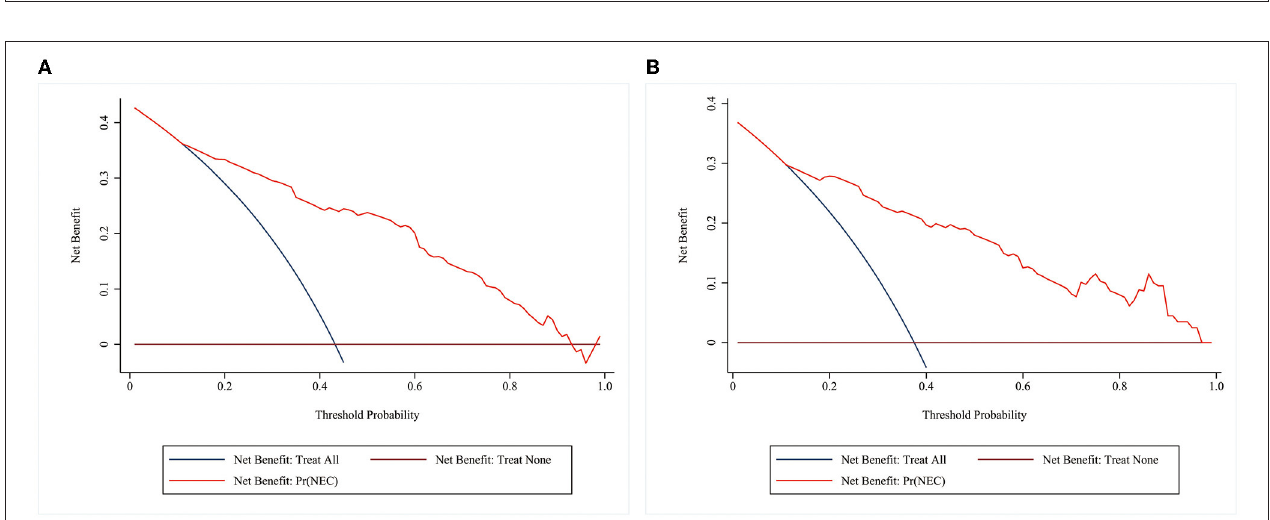
FIGURE 4 | Calibration curves of the models in the training and validation groups . The closer the solid blue line is to the red dashed line with a slope of one, the better the model is calibrated. A level p > 0.05 in the two figures indicates no statistically significant difference between the predicted incidence curve and the actual incidence curve. (A) Calibration curves of the model in the training group. (B) Calibration curves of the model in the validation group.